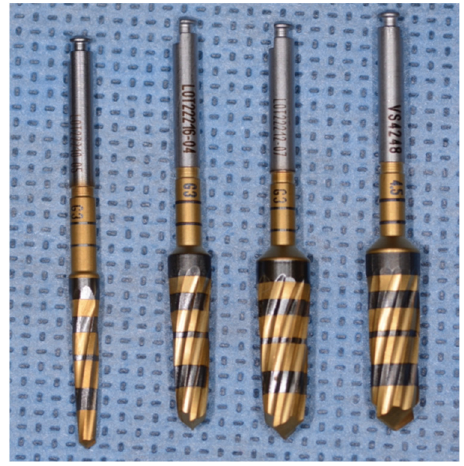
Figure 5. The Densah ® burs used in the study (2.3, 4.0, 4.3, and 4.5 mm).